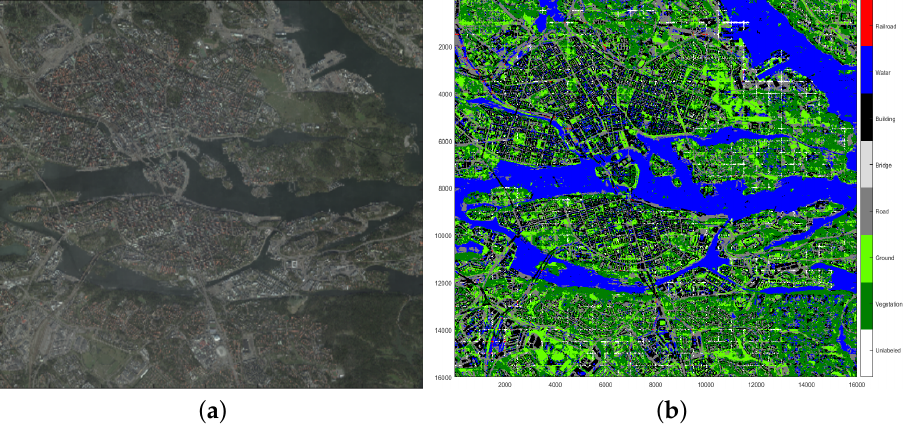
Figure 9. ( a ) Stockholm’s Satellite Data (as large as 64 km 2 ) ; ( b ) Approximately 115,000 classified regions in Stockholm.